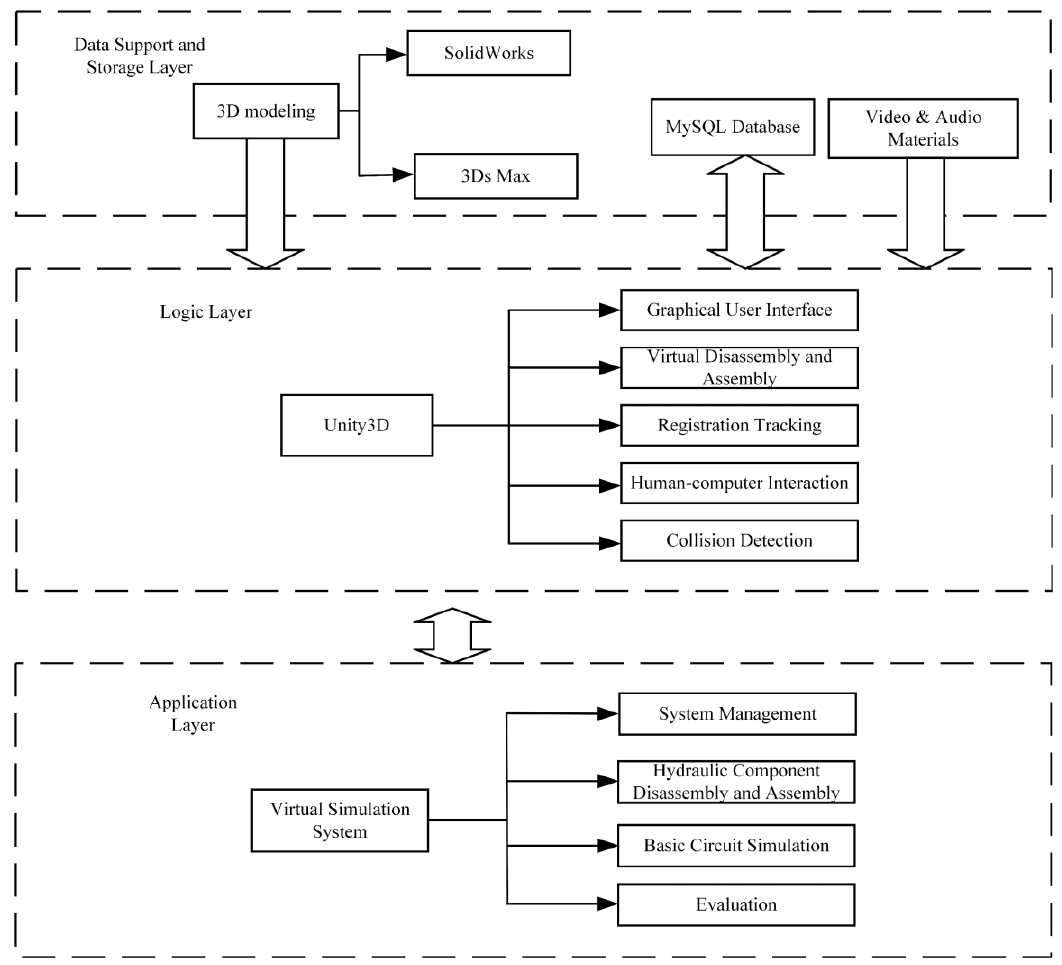
Figure 4. Development framework diagram of the hydraulic transmission teaching